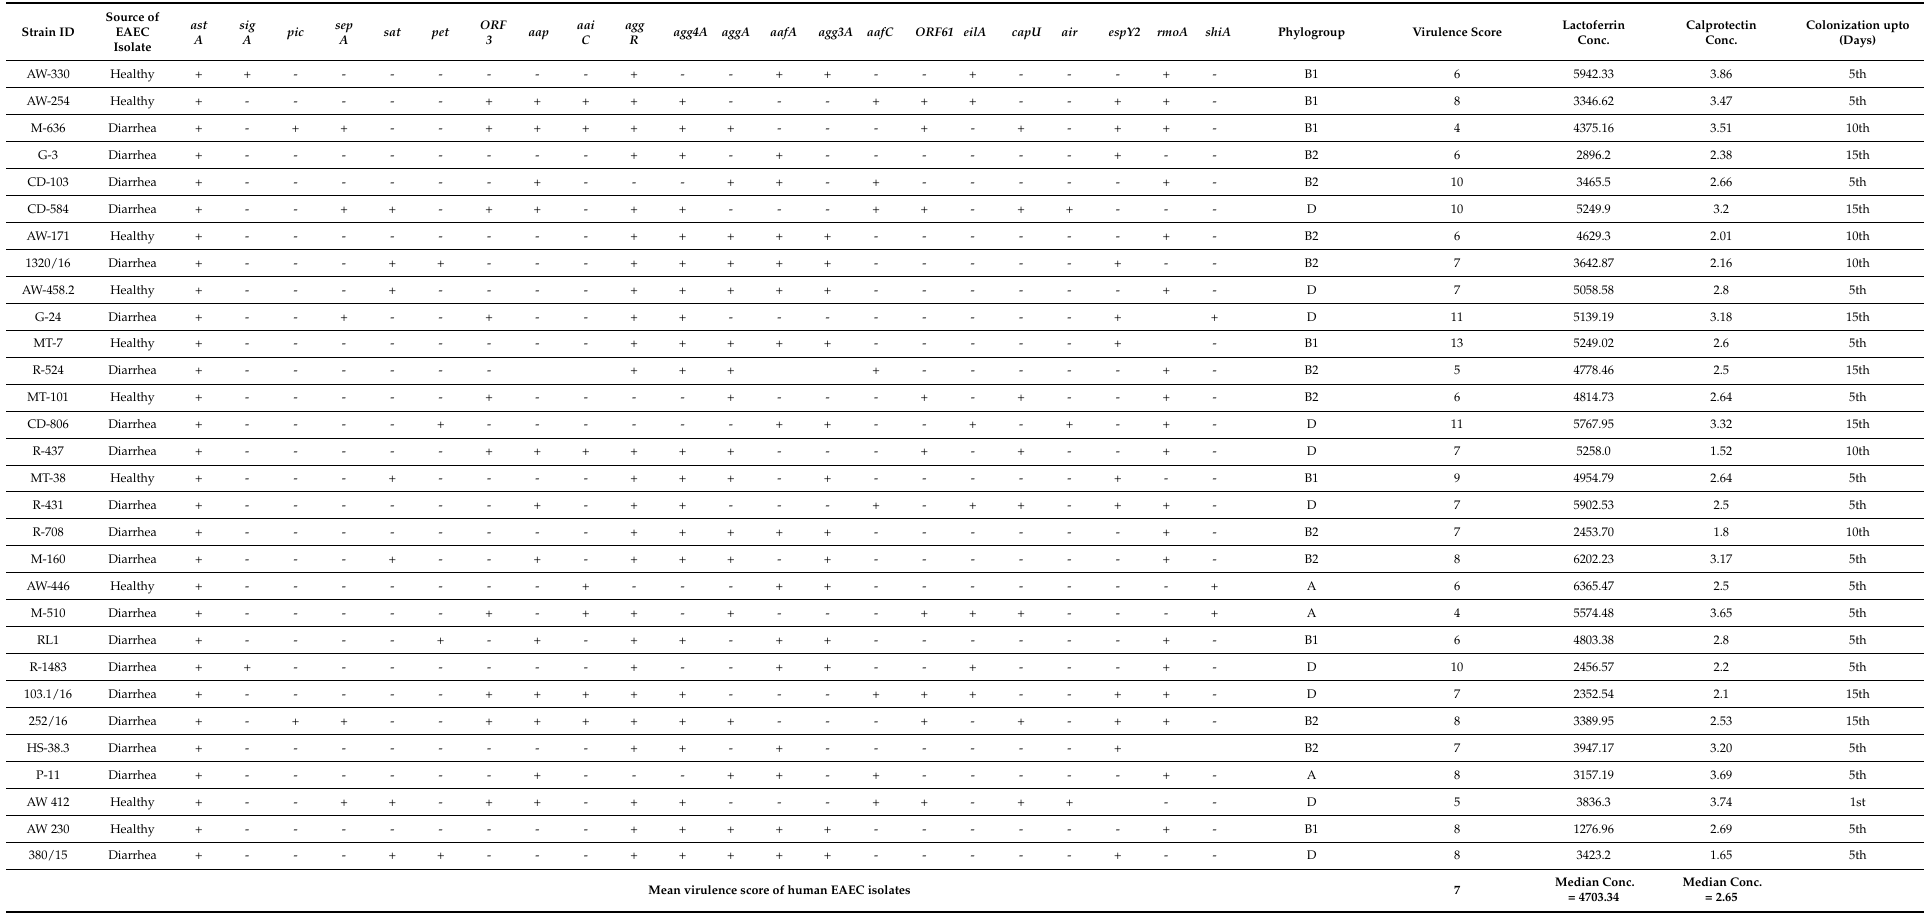
Table 2. The virulence genes’ content and phylogroups. Inflammatory markers and colonization of each strain from human sources.